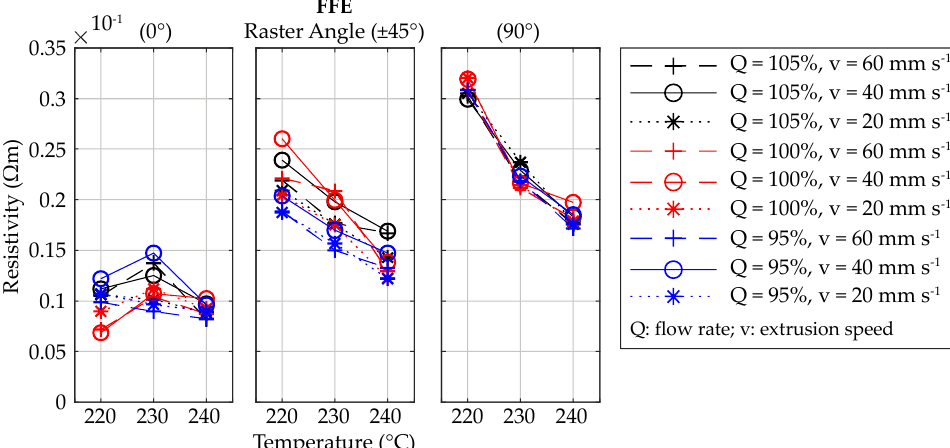
Figure 12. Dependencies of the resistivity of FFE regarding temperature, extrusion speed and flow rate structured by raster angle.